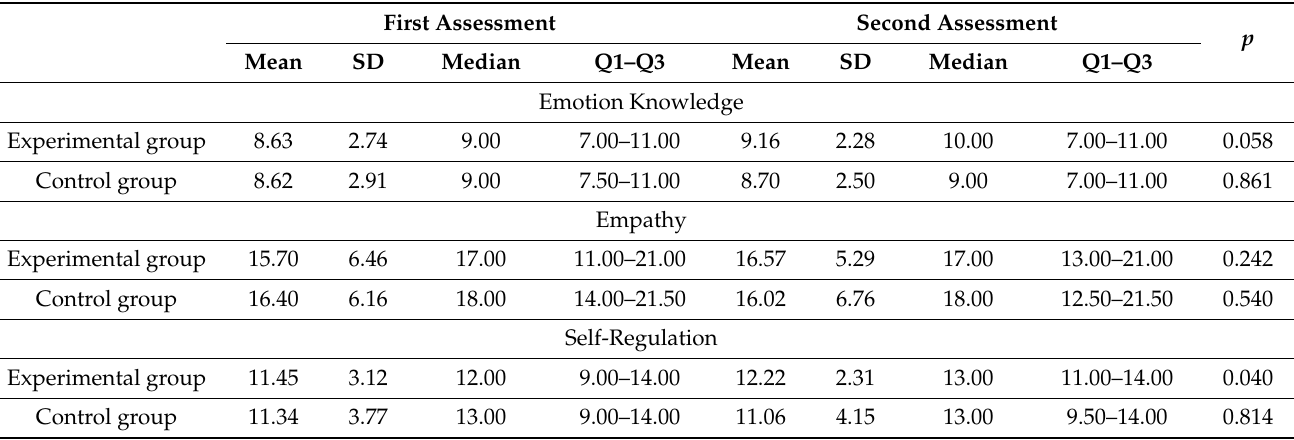
Table 8. Changes in the EMK screening results when comparing the first and second assessment data in the experimental and control